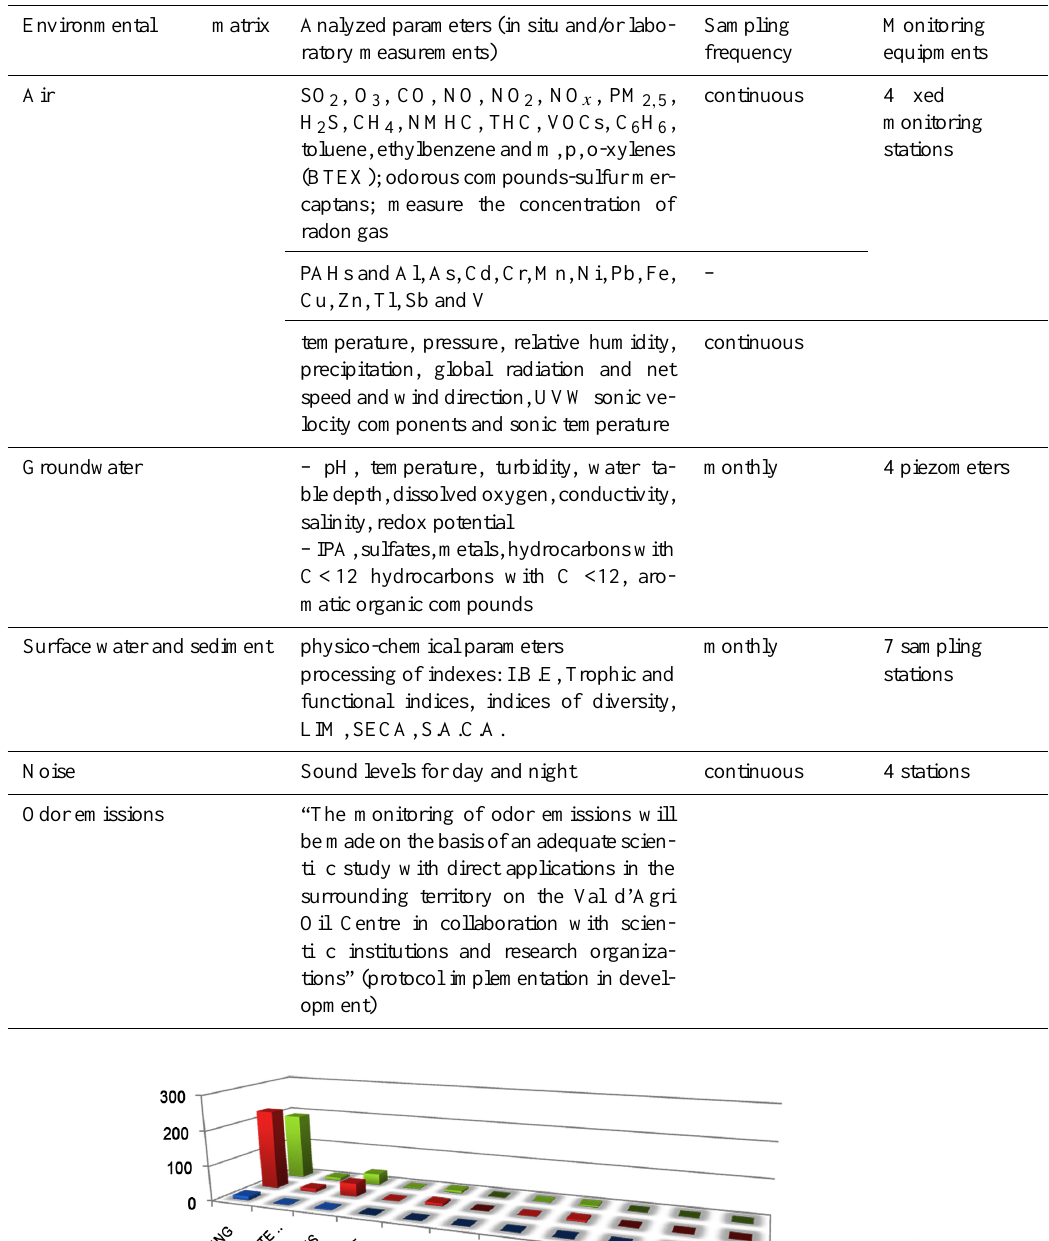
Table 8. Framework of synthesis parameters, and monitored environmental components. Source: OAVDA.